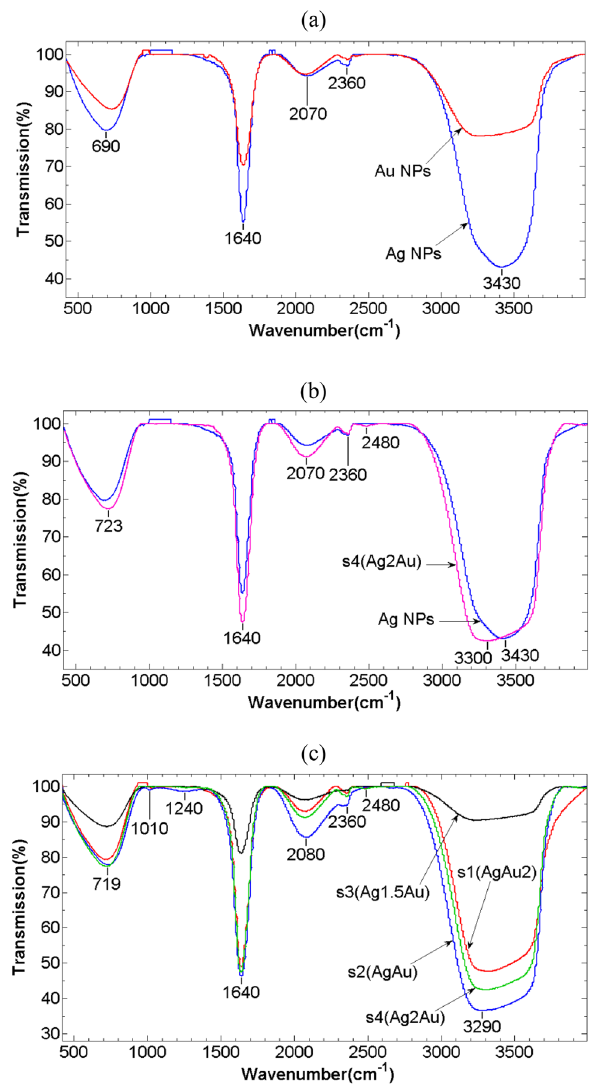
Fig. 13 Fourier transform infrared (FTIR) spectrum Au/Ag BNPs a , synthesized s4 and bulk AgNPs b and Au and AgNPs c with second harmonic irradiation